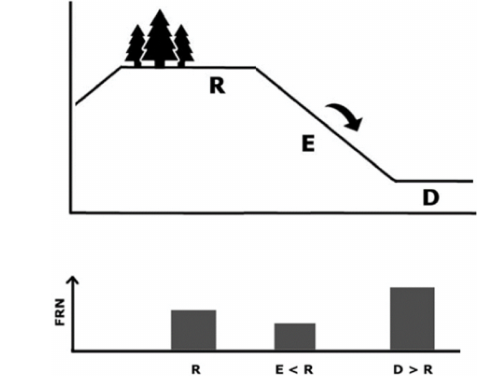
Figure 1. Concept of the fallout radionuclide (FRN) traditional method, in which the FRN content of a reference site located in a flat and undisturbed area (R) is compared to the FRN content of disturbed sites (E and D). If the FRN at the site under investigation is lower than at the reference site, the site has experienced erosion processes (E). If the FRN content is greater than at the reference site, the site has experienced deposition processes